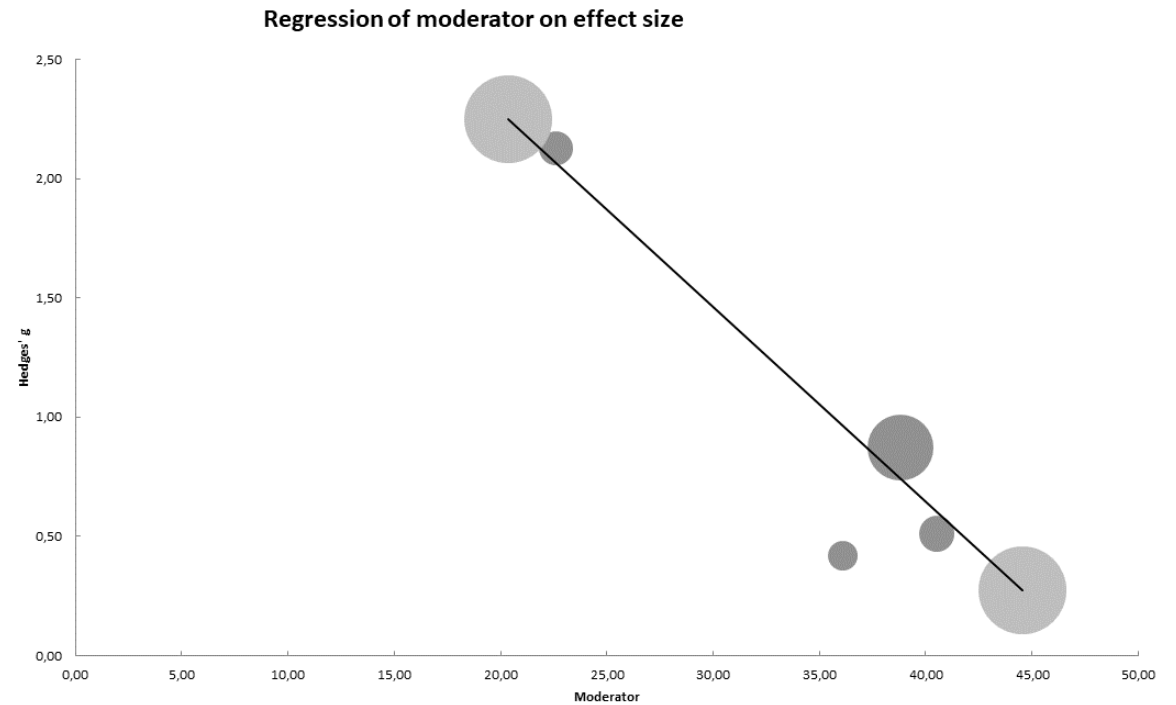
Figure 7. Meta-regression of pain intensity and VO 2 max scores. The meta-regression approach uses regression analysis to determine the influence of selected variables (the independent variables) on the effect size (the dependent variable). The large bubbles, together with the line, indicate the relationship of our model, and the small bubbles indicate their position, the relationship in the map of the effect size on the decrease in pain, on the score in the variable of maximal oxygen consumption.